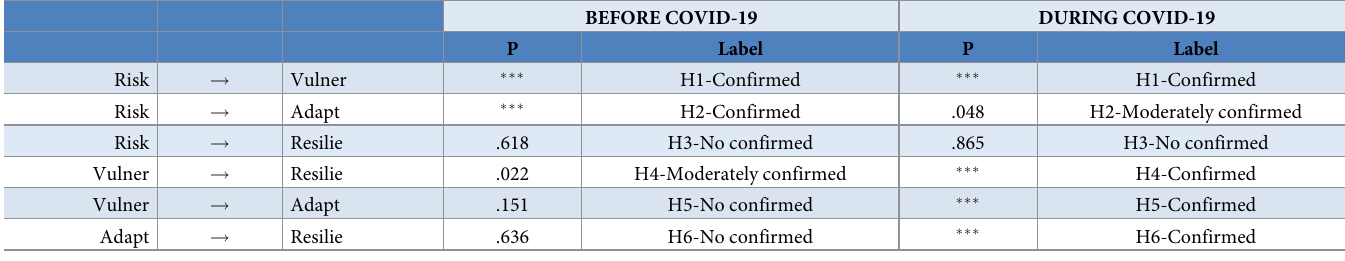
Table 6. Regression w eights (Default